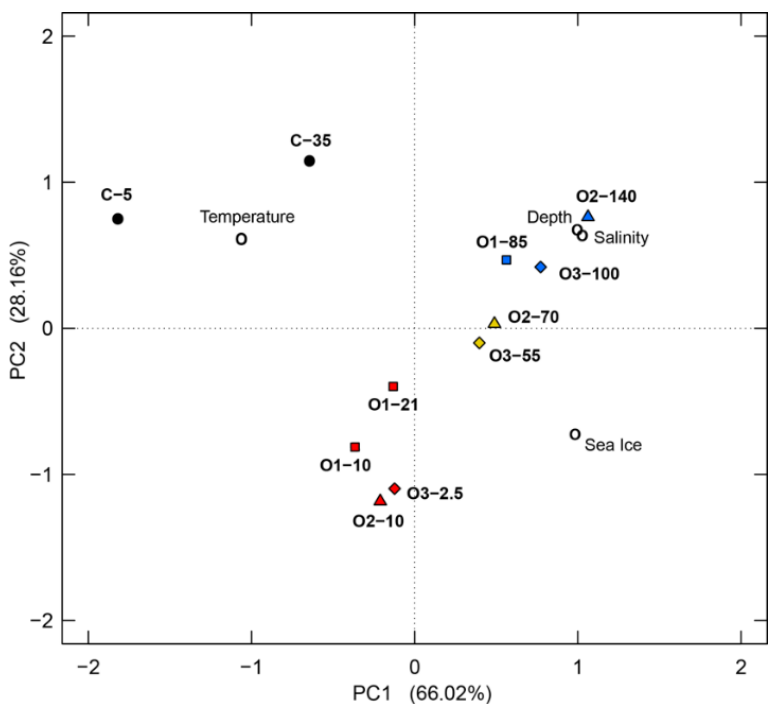
Figure 2. Principal component analysis (PCA) based on the environmental properties of the 11 samples. The open circles represent the environmental properties and the closed symbols represent the samples. The samples are colored according to water mass: red, UPML; yellow, LPML; blue, PSW; black, coastal. The shapes represent di ff erent stations: C, circles; O1, squares; O2, triangles; O3, diamonds.